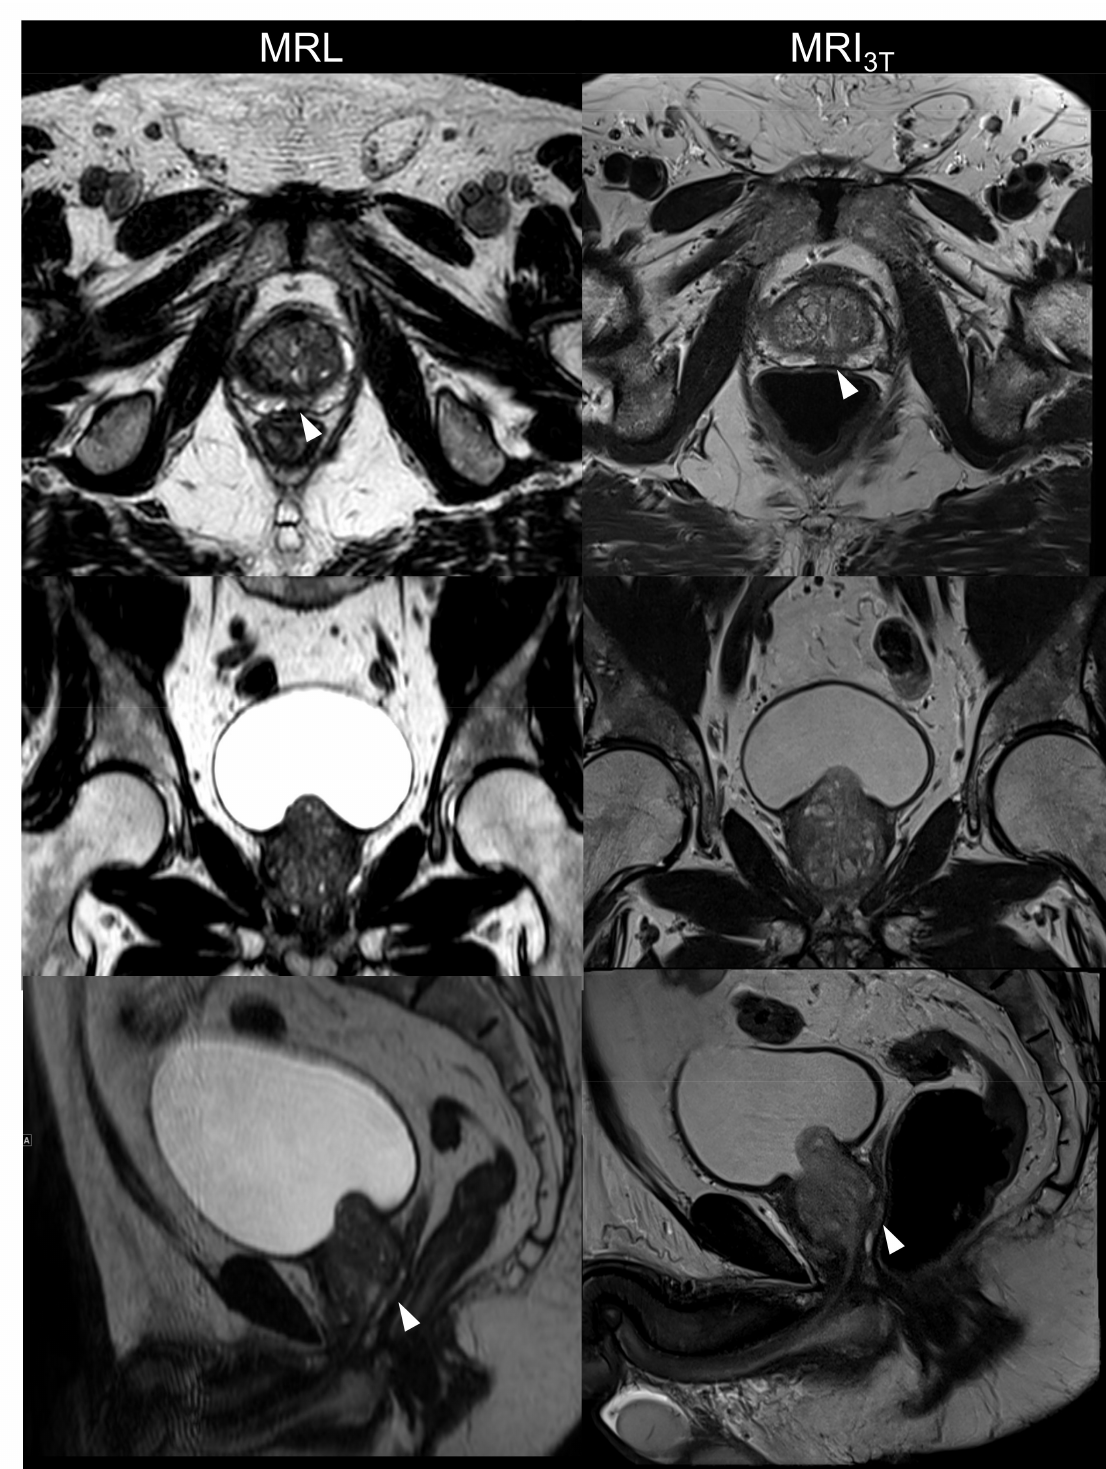
Figure 3. Illustration of T2-weighted axial ( first row ), coronal ( second row ) and sagittal ( third row ) images acquired using MR-Linac (MRL) at 1.5 T and corresponding images recorded on a standard MRI at 3 T (MRI 3T ) of the same 73-year-old male as in Figure 2. Diffusion-weighted images (DWI) and apparent diffusion coefficient (ADC) maps are depicted. The cancerous lesion on the apical posterior-medial aspect of the left peripheral zone is shown on the axial and sagittal images